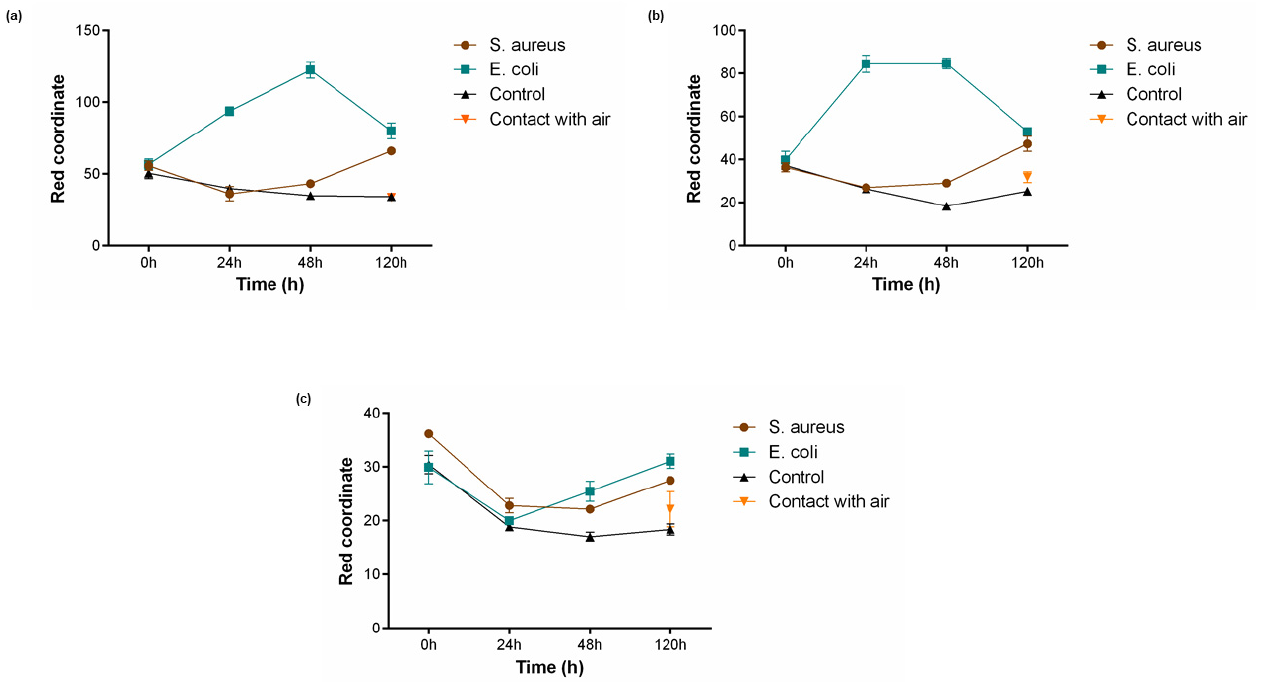
Figure 5. Bacterial sensing activity of polyester functionalised with Prussian blue (PB) at ( a ) 0.5 g/L, ( b ) 1 g/L and ( c ) 2 g/L. Colour change is represented by a shift in the red channel coordinate measured through the RGB model, after incubation with S. aureus (10 8 CFU/mL) and E. coli (10 8 CFU/mL) for 120 h in 1 M MES buffer (pH 6.1) and 1% ( w / v ) of glucose, (n = 3, ± SD). Control is represented as the condition where the textiles were incubated without bacterial culture and contact with air refers to a sample left in atmospheric conditions for the whole duration of the assay.